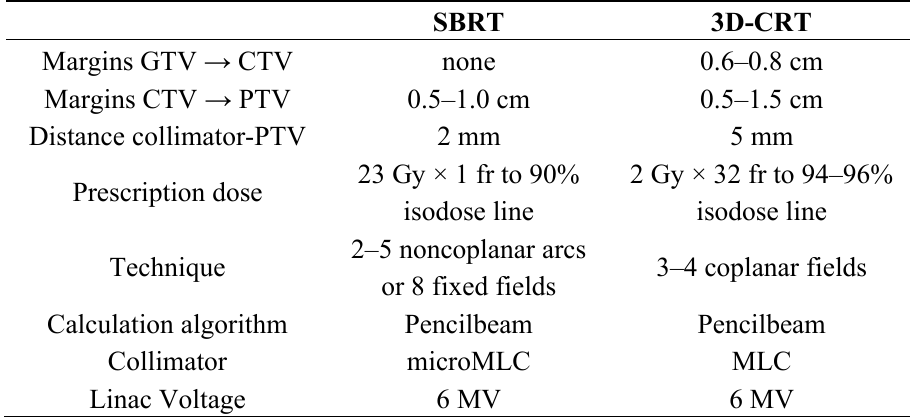
Table 2. Geometrical features and fractionation schemes of SBRT and 3D-CRT plans generated with